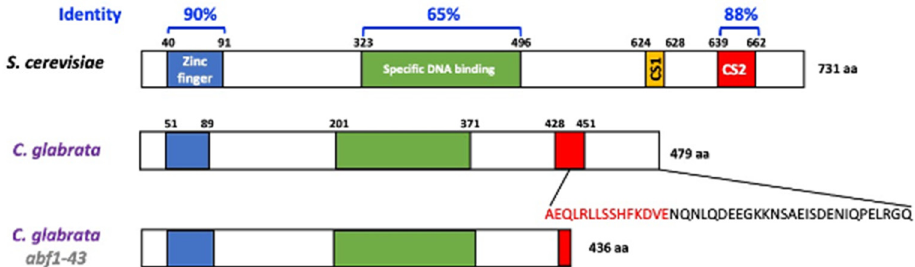
Figure 1. C. glabrata encodes the Cg Abf1 protein with conserved DNA-binding and regulatory domains. Schematic representation of Abf1 from S. cerevisiae and C. glabrata , Cg Abf1 has 479 aa and Sc Abf1 has 731 aa. The overall identity between Sc Abf1 and Cg Abf1 across the entire length of the proteins is 63.87%. The blue and green rectangles correspond to the DNA binding domains, the yellow rectangle corresponds to the CS1 domain in Sc Abf1 and the red rectangles to the CS2 domain responsible for chromatin remodeling and transcriptional regulation. Alignments were performed using ClustalW with the program McVector. We generated a CgABF1 truncated allele, Cgabf1-43 , which lacks the last 43 amino acids of Cg Abf1, deleting 15 highly conserved residues at the CS2 domain (in red letters) that mediate transcriptional silencing in S. cerevisiae (See Materials and Methods). The structure of the Abf1-43 truncation mutant protein is shown at the bottom (total of 436 amino acids).